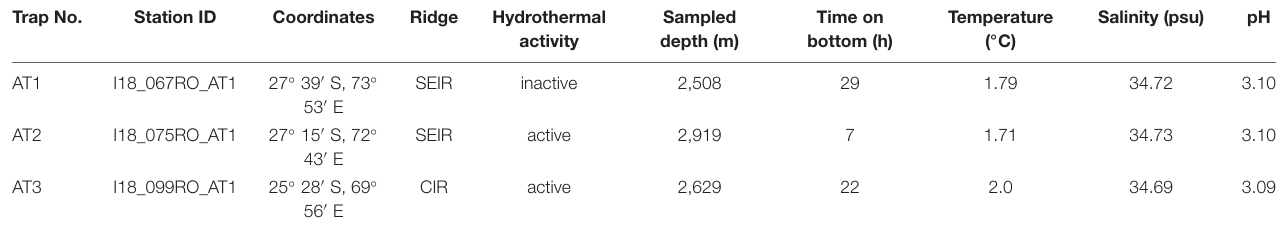
TABLE 1 | Deployed amphipod traps with station ID, coordinates, ridge (Central Indian Ridge = CIR, Southeast Indian Ridge = SEIR), hydrothermal activity, collection depth, the deployment time of the trap on the seafloor and the measured environmental parameters (temperature, salinity, and pH-value). Trap